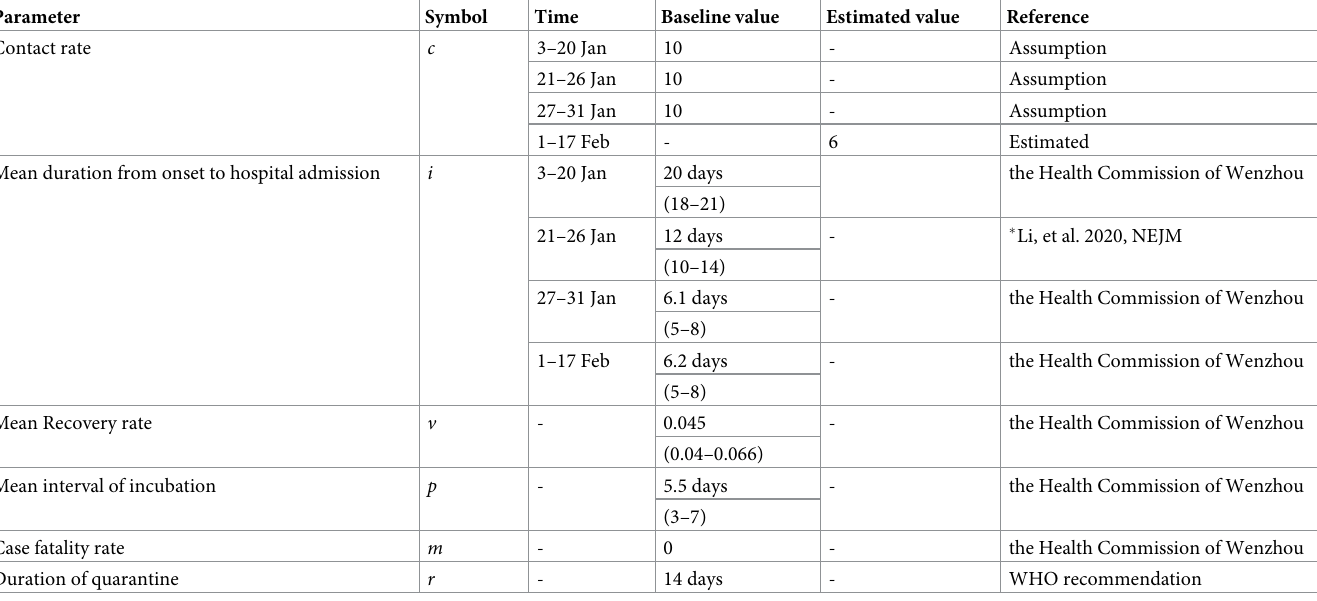
Table 1. Parameters used in the quarantine simulation of Wenzhou